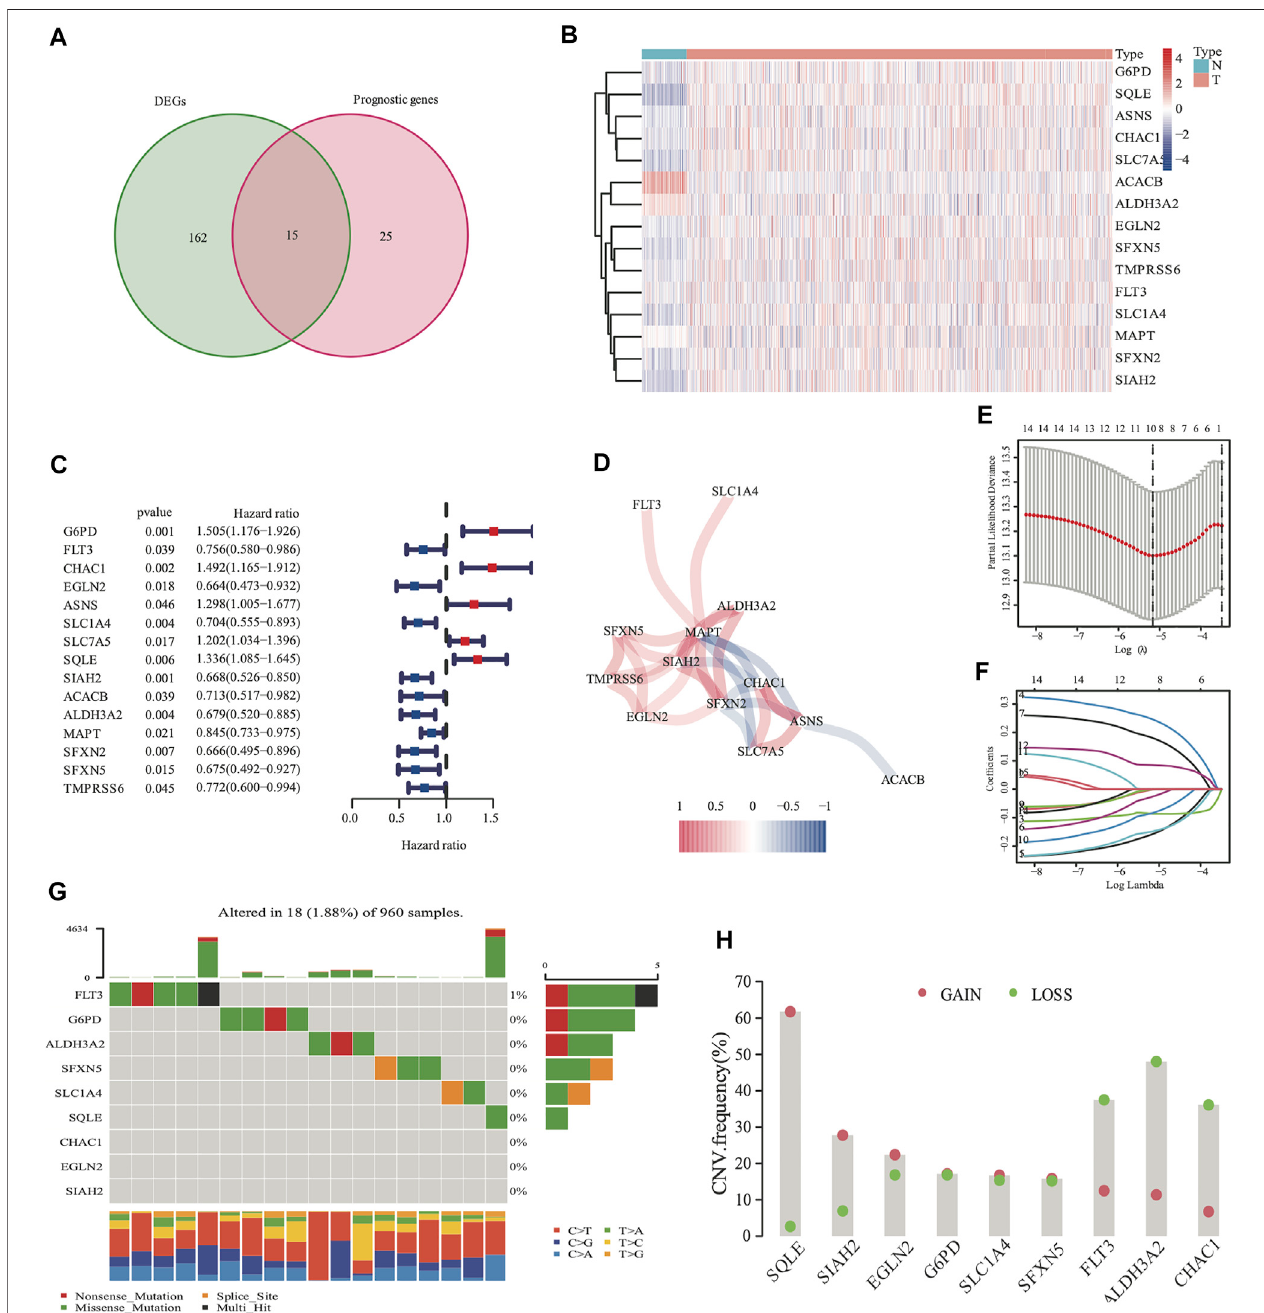
FIGURE 2 | Identi fi cation of 177 differentially expressed genes (DEGs) and 40 DSS prognostic FRG. A venn diagram was used to identify overlapping genes (A) . Heatmap showed that 15 FRG were differentially expressed in breastcancer tissuesand non-cancer tissues (B) Forest plotsdemonstrated the hazard ratioofthe univariate coxanalysesinDSS (C) .ThecorrelationlinkoftheselectedgenesinTCGAcohort (D) .Lassoregressionanalysisreducedvariable (E,F) .SomaticmutationsonaqueryofFRG from TCGA cohort (G) The CNV frequency of FRG from the TCGA cohort (H) , red dots represent CNV ampli fi cation, while green dots represent CNV deletion.